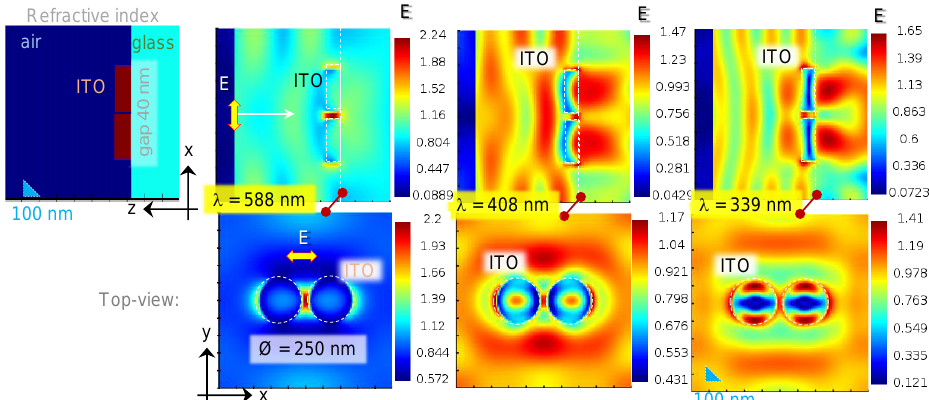
Figure A1. FDTD calculation of light-intensity distribution (within 1 µ m 3 volume) for an array of ITO nano-disk pairs; period in XY-plane is Λ x , y = 1 µ m, diameter of ITO disk 2 r = 250 nm, the gap ∆ x = 40 nm, height of disk h = 80 nm. Light source is a plane wave with a normalised E-field | E | 2 = 1. Glass is defined as dielectric with refractive index n = 1.4 and the complex refractive index of ITO [36] was added to Lumerical material database as a table. Top-row is the side-view and bottom-row is the top-view E -field enhancement